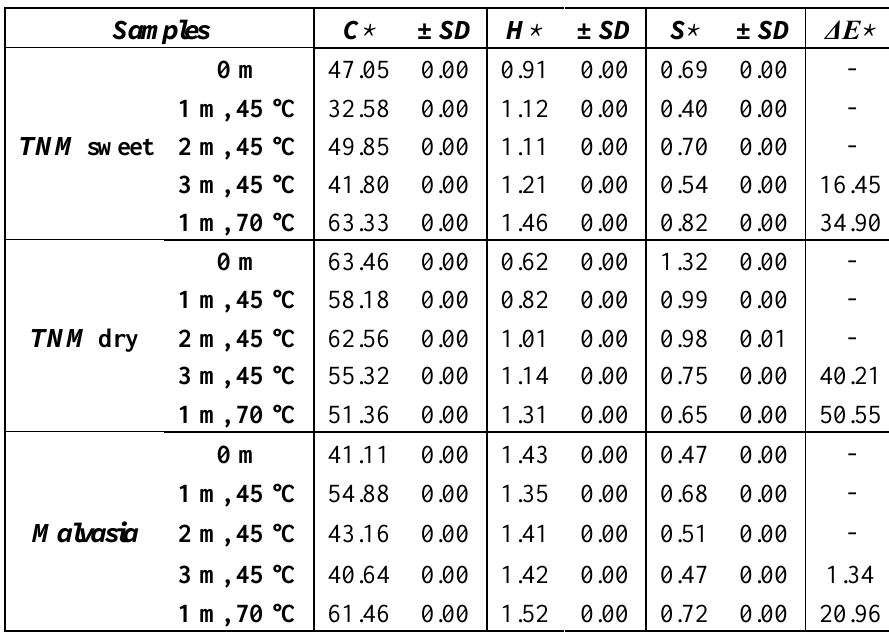
Table 8. CIELab chromatic parameters: chromaticity ( C* ), hue ( H* ) and saturation ( S* ) of the Madeira wines submitted to heating at 45 °C (3 months) and 70 °C (1